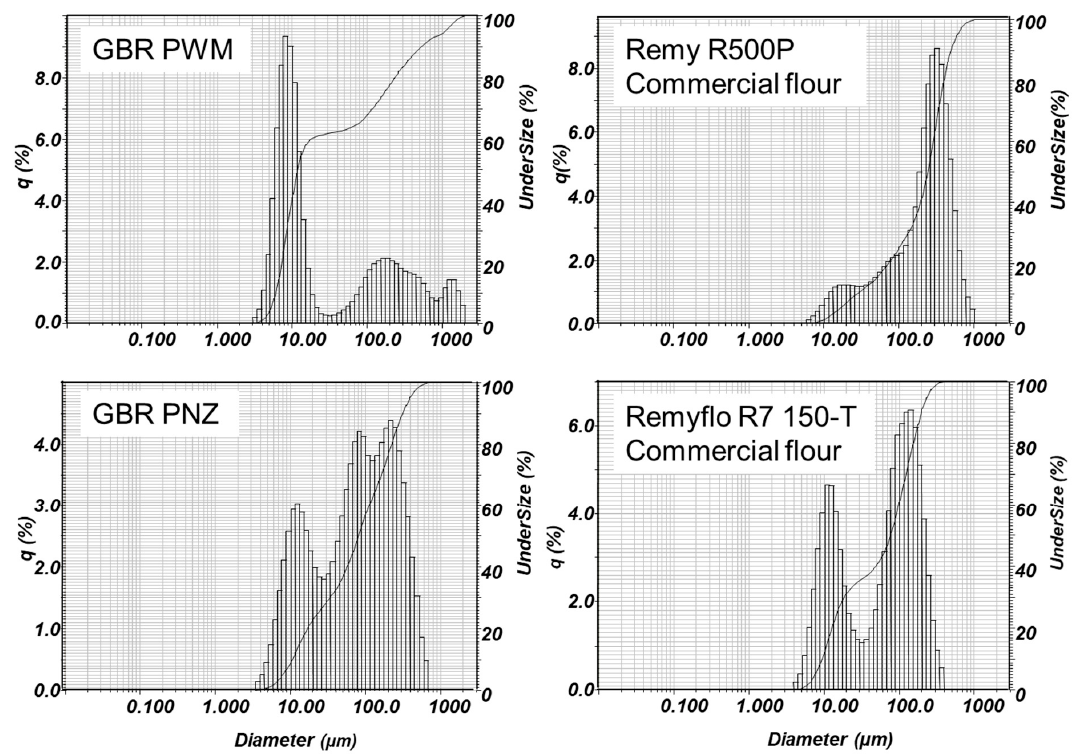
Figure 1. Typical Horiba particle size distribution plots for germinated brown rice (GBR), post wet milling (PWM) and post-enzyme (PNZ), and two commercial white flours: Remyflo R7 150-T and pre-cooked Remy R500P. The y-axis q (%) indicates the amount of each size by volume. Viscosity data indicate that both WR and BRR PWM samples were significantly more viscous than GBR PWM samples (Table 2). Meanwhile, both GBR and BRR PNZ viscosities were significantly